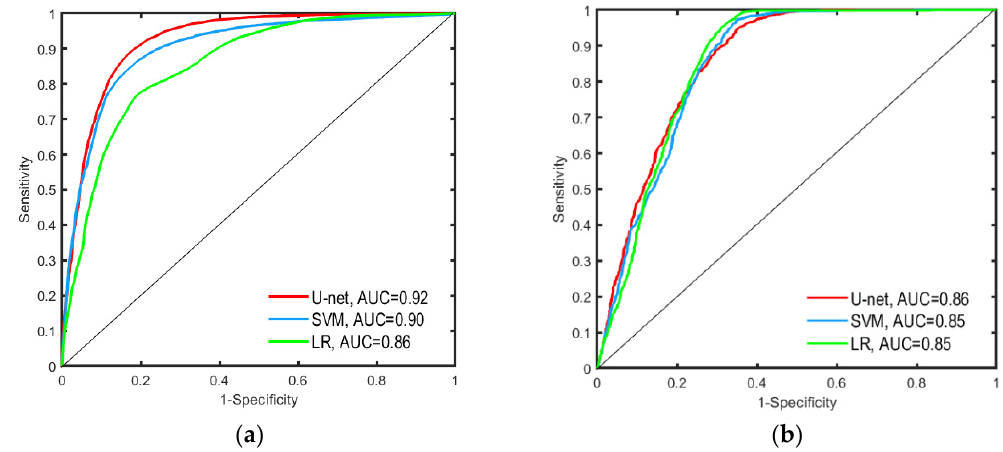
Figure 16. ( a ) Receiver operation characteristic (ROC) curves for three models using test dataset 1; ( b ) ROC curves for three models using the test dataset 2.